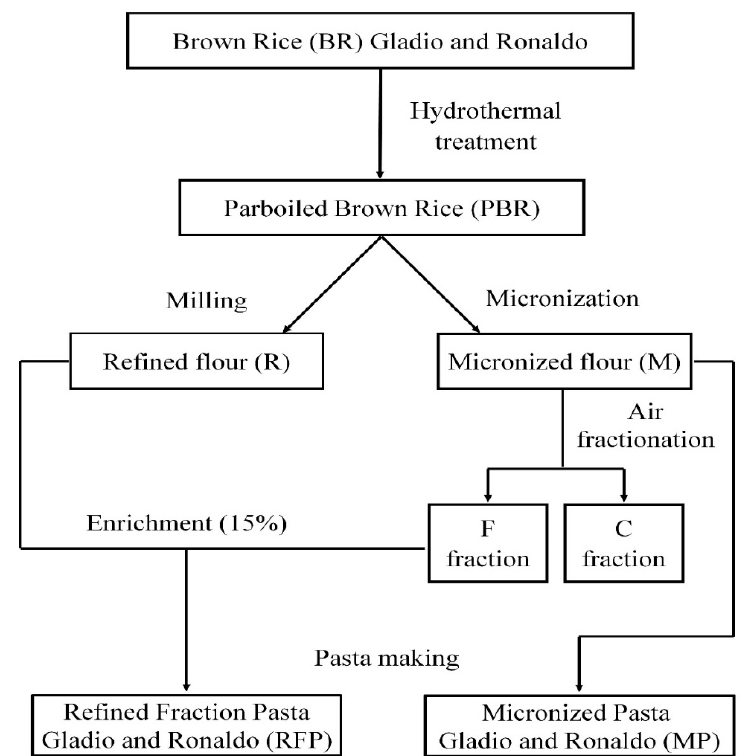
Figure 1. Flow chart of the technological processes applied to the two rice cultivars Gladio and Ronaldo.